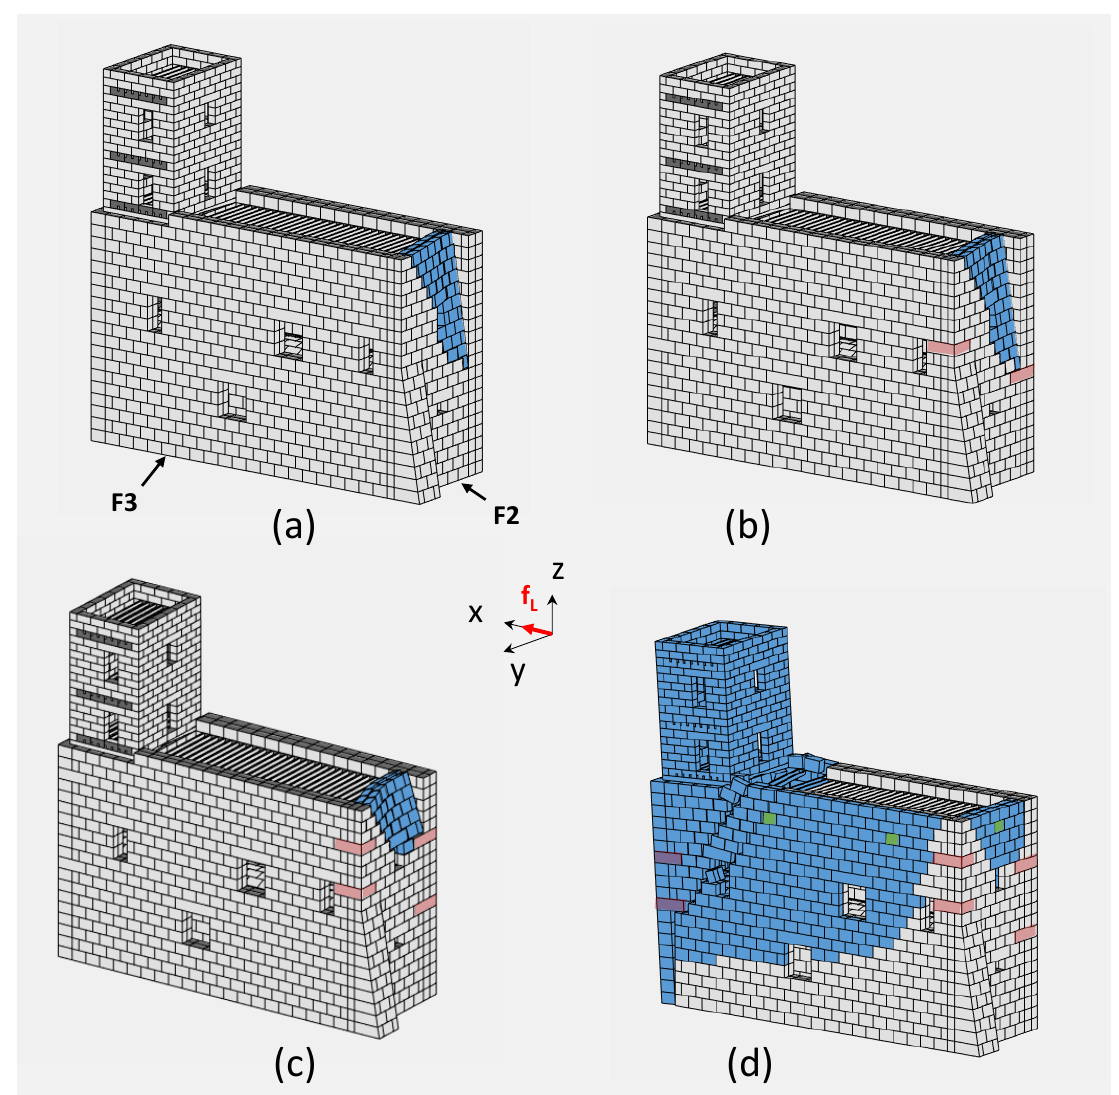
Figure 12. Collapse mechanisms and participating masses (in blue) provided by LiABlock_3D for the load case LC1 (live loads f L along the positive x-axis): ( a ) the castle wing in its present conditions; ( b ) retrofitting intervention n.1 (R1); ( c ) retrofitting intervention n.2 (R2); ( d ) retrofitting intervention n.3 (R3). Quoins in red; washer-bearing plates in green.